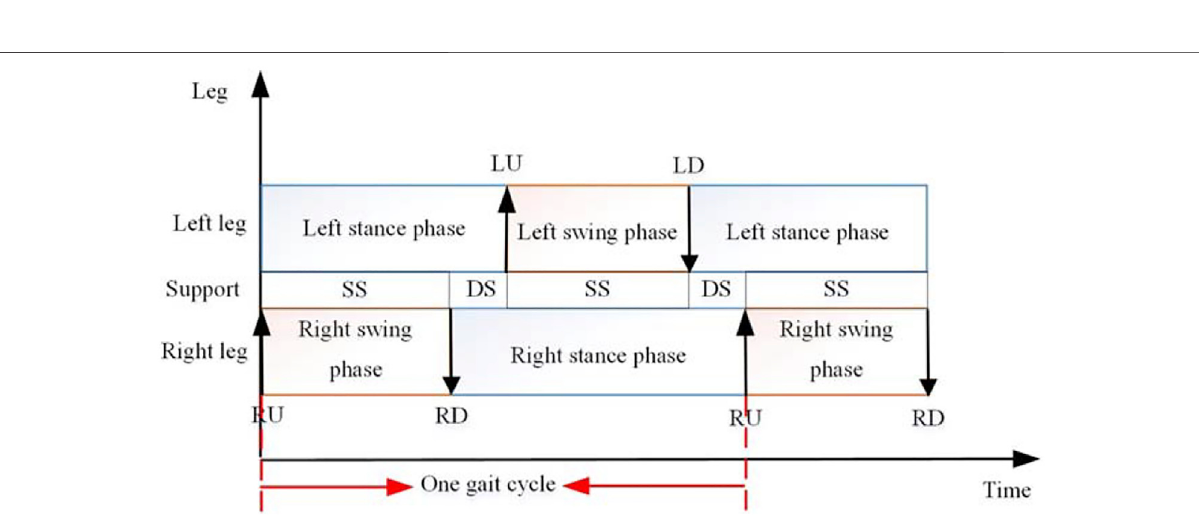
Frontiers in Robotics and AI |